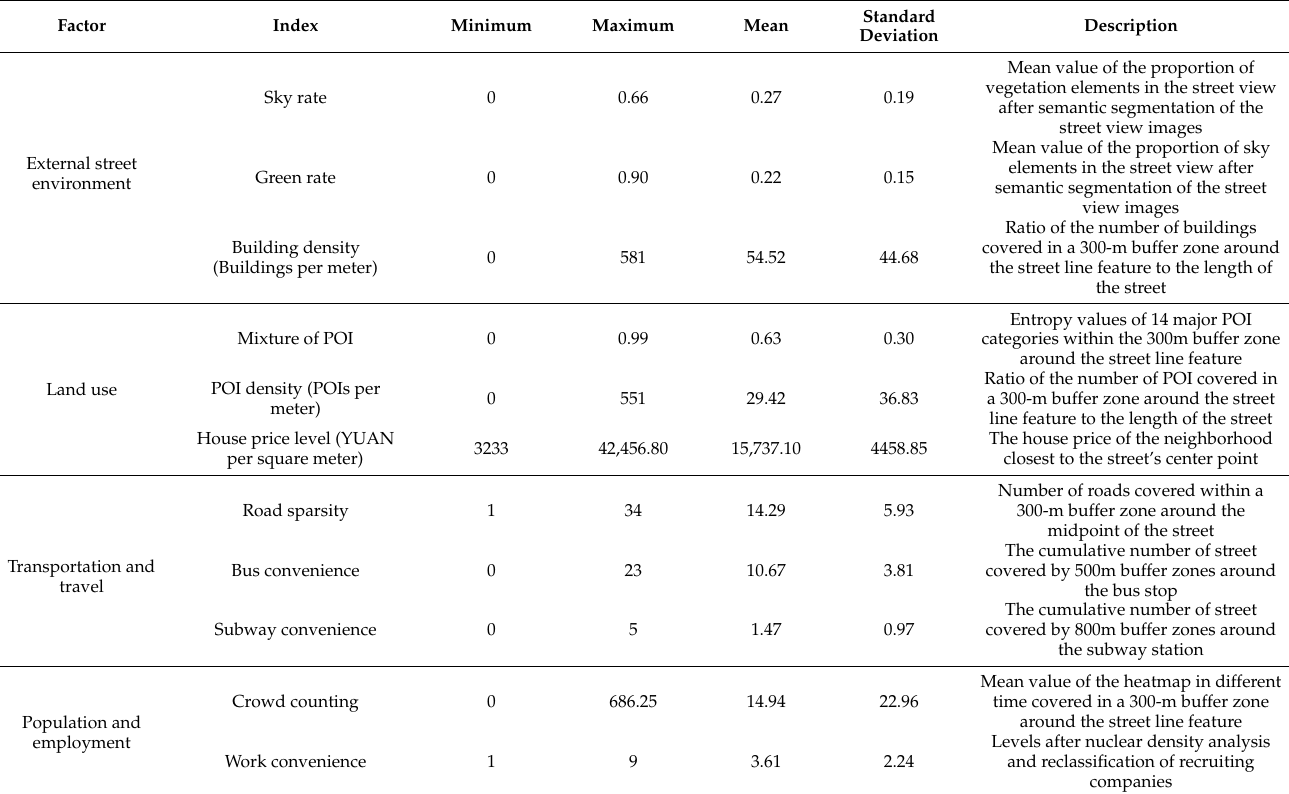
Table 2. Descriptive statistics of built environment factors on